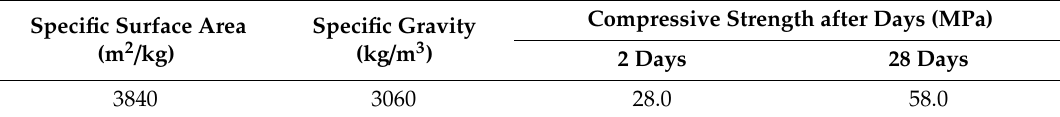
Table 2. Physical properties of cement.